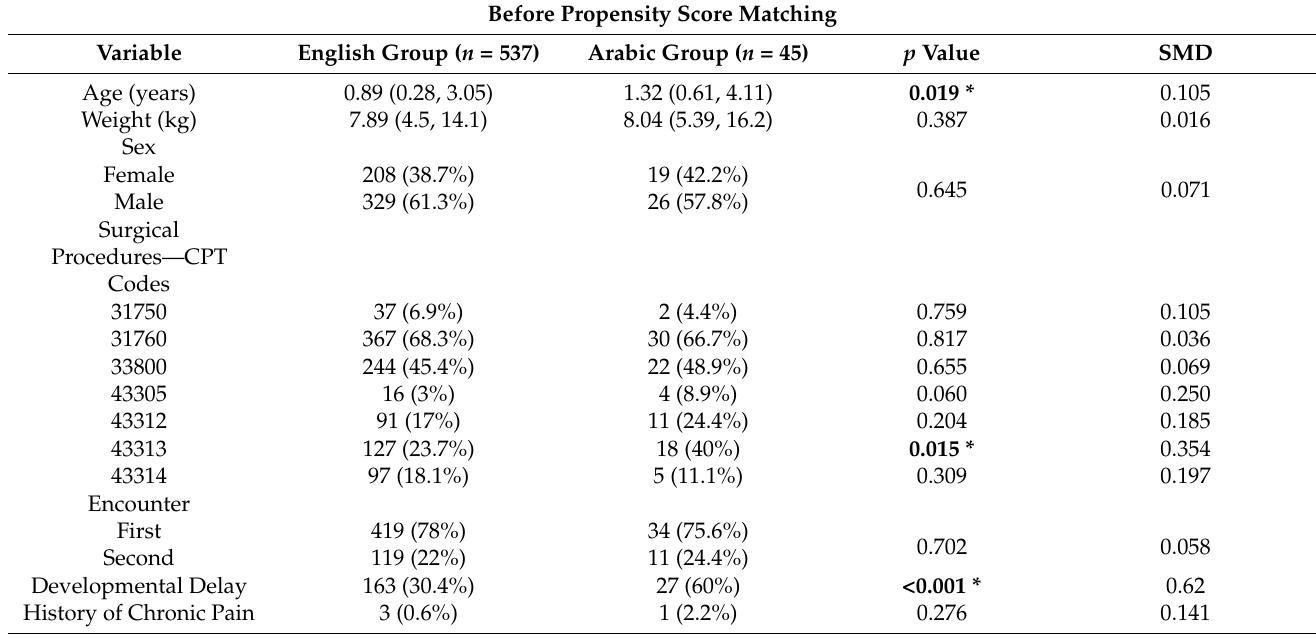
Table 2. Patient Characteristics Before and After Propensity Score Matching Between English- and Arabic-Speaking